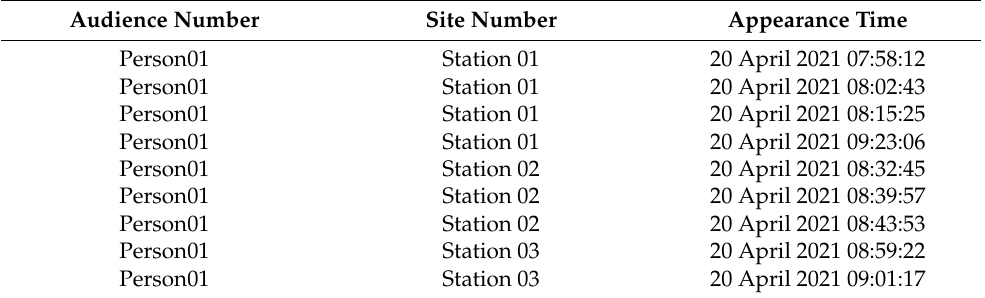
Table 4. Specific audience data.